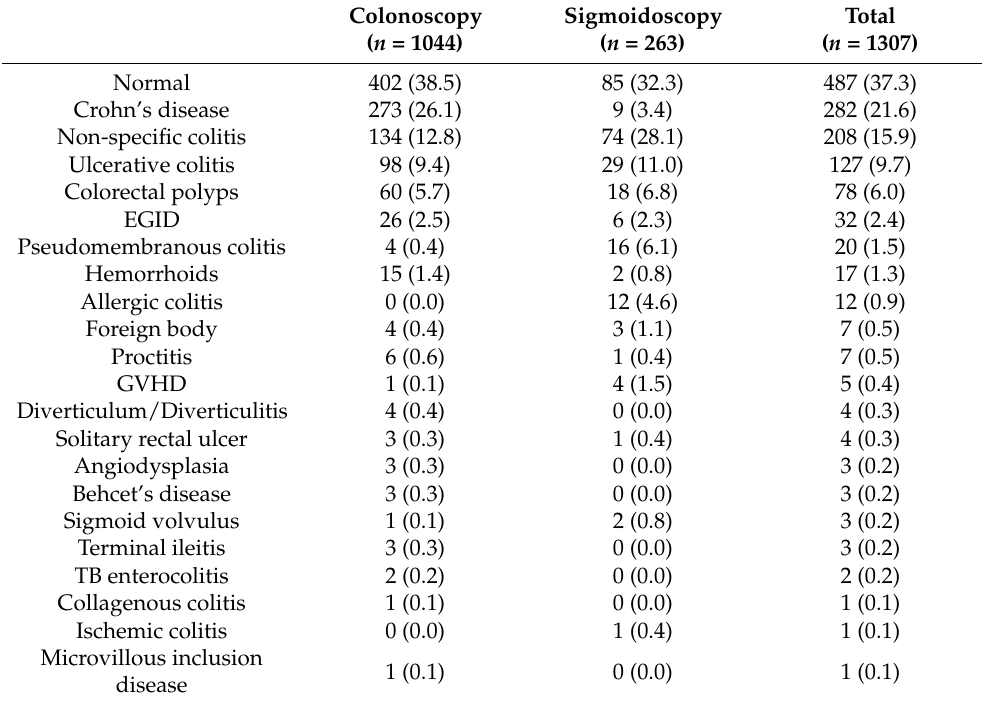
Table 3. Diagnosis of patients based on clinical and endoscopic